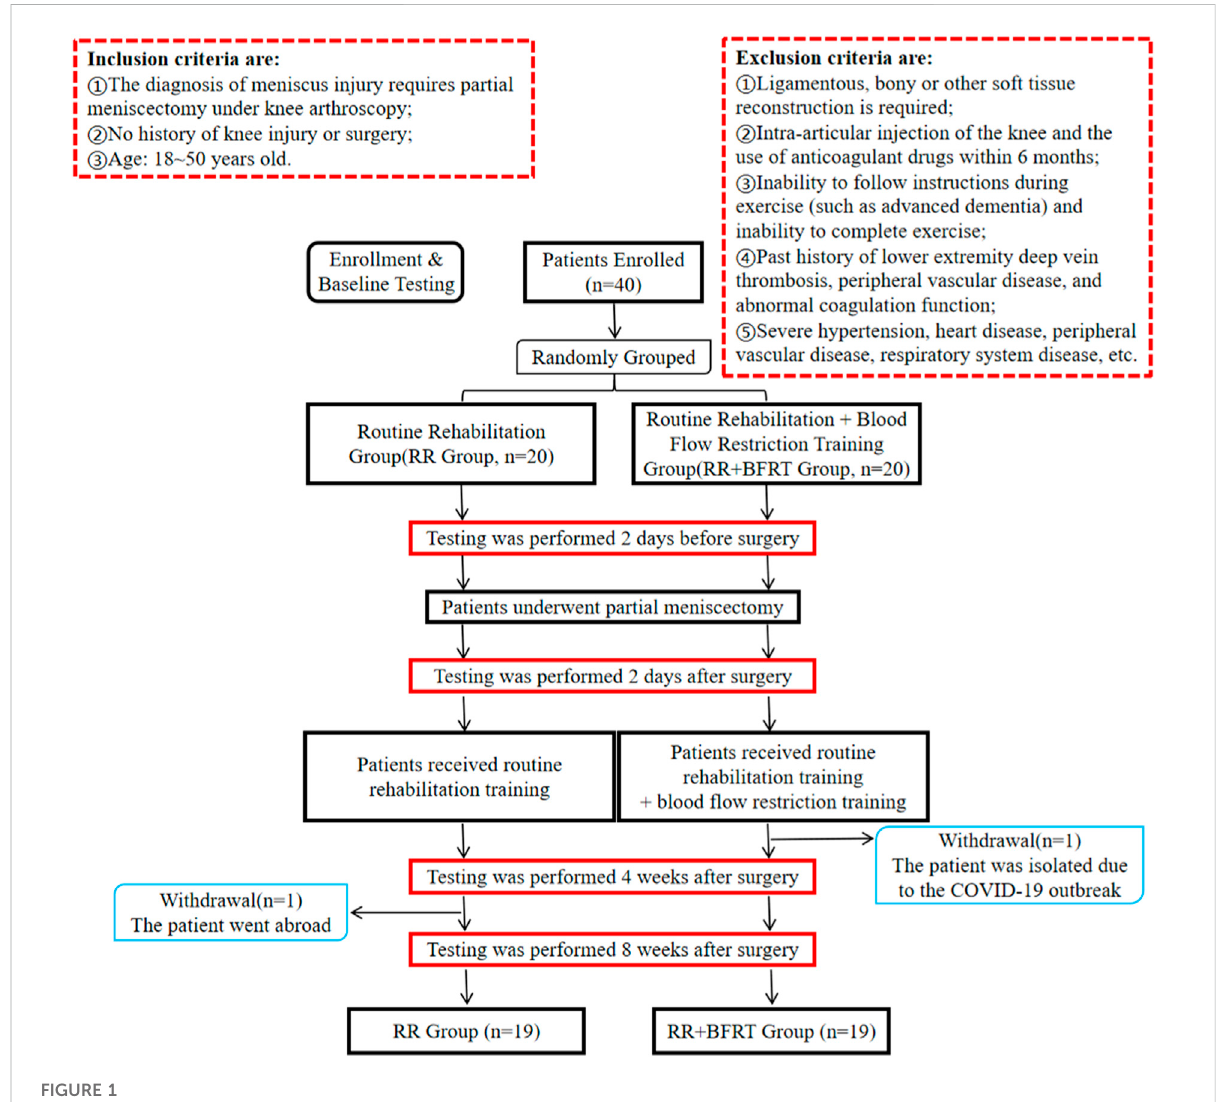
FIGURE 1 Flowchart overview of the